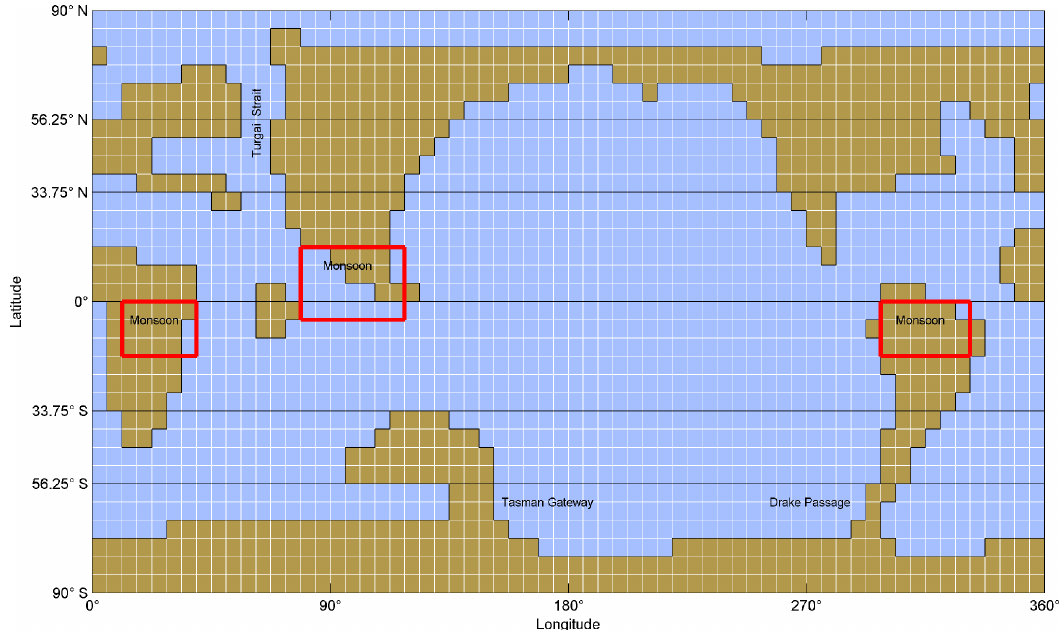
Figure 1. Eocene palaeogeography and geographic areas used to determine simple metric values.